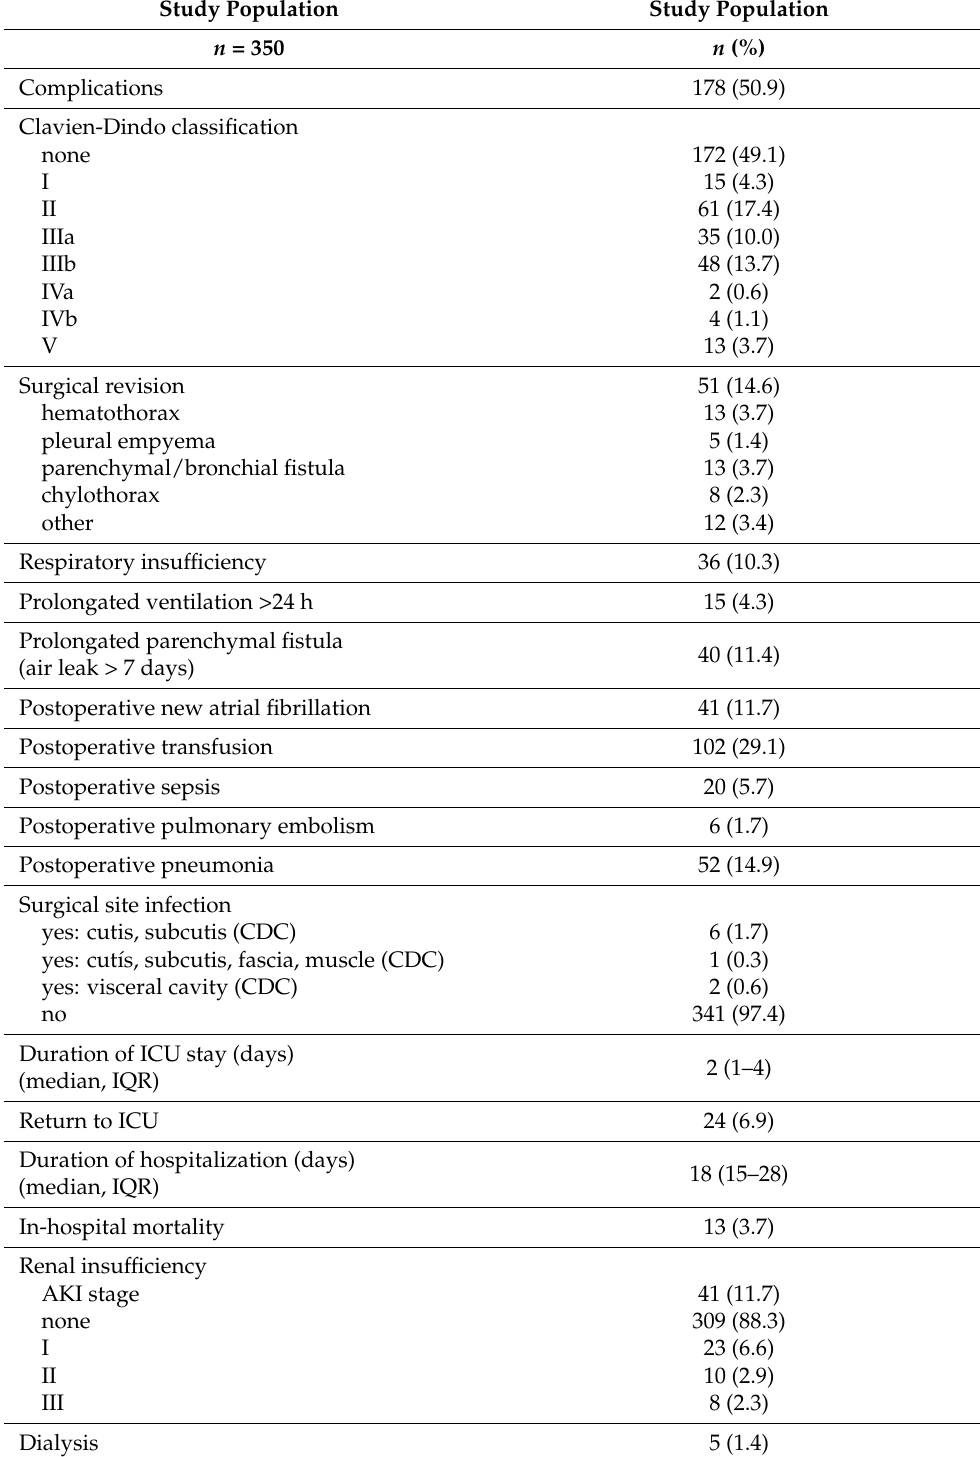
Table 3. Postoperative treatment